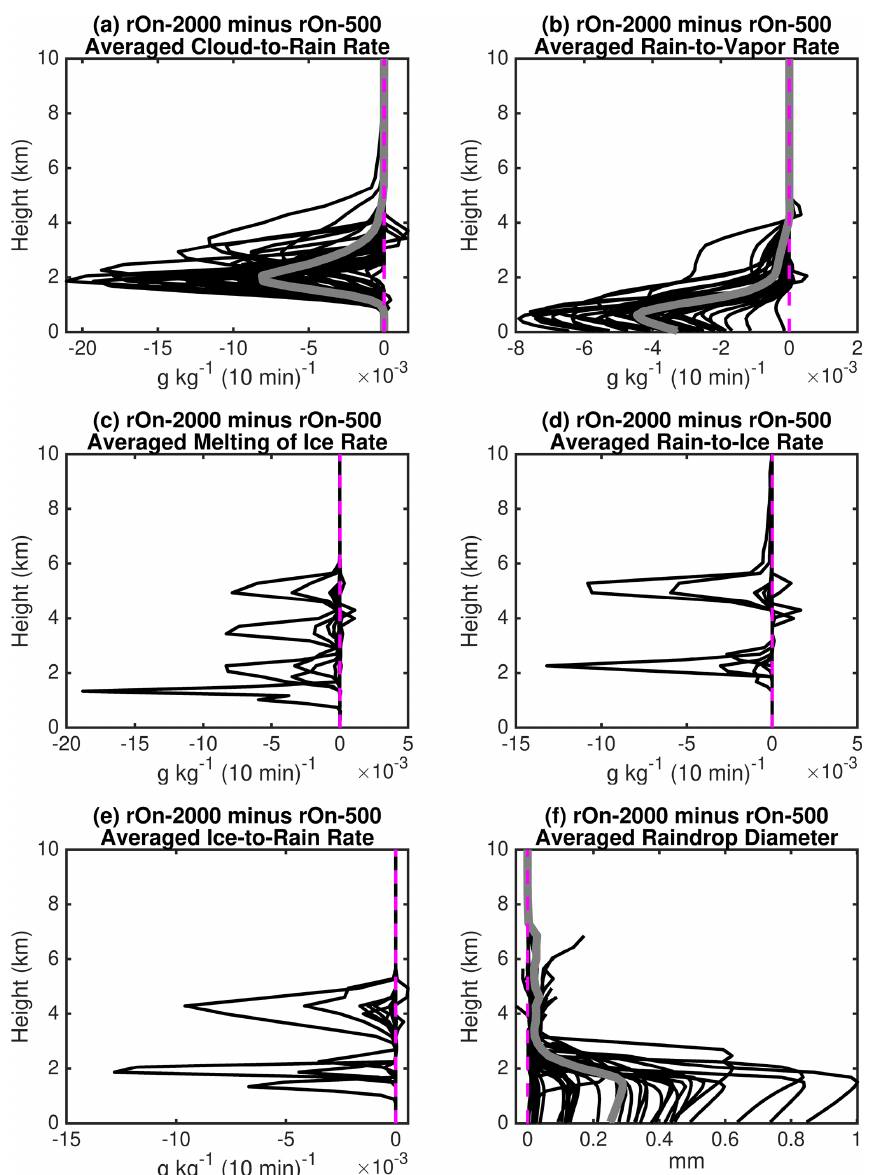
Figure 11. Aerosol-induced differences to the processes generating rain for the range of environmental conditions tested in these large ensemble experiments. Shown are the rOn-2000 minus rOn-500 differences, for (a) cloud to rain, (b) rain to vapor, (c) melting of ice, (d) rain to ice, and (e) ice to rain rates (see the text for an explanation of these processes), using the 36 ensemble pairs that produce at least 0.1mm of land-averaged surface accumulated precipitation in rOn-500. Process rates are averaged over the land domain between 12:00 and 18:00LT. (f) The rOn-2000 minus rOn-500 raindrop diameter averaged over the land between 12:00 and 18:00LT. The thin black lines in all of the figures are from all 36 pairs, and the thick gray lines in panels (a) and (b) are the means of the rOn-2000 minus rOn-500 for the 36 pairs. The dashed magenta lines indicate where the difference between rOn-2000 and rOn-500 is